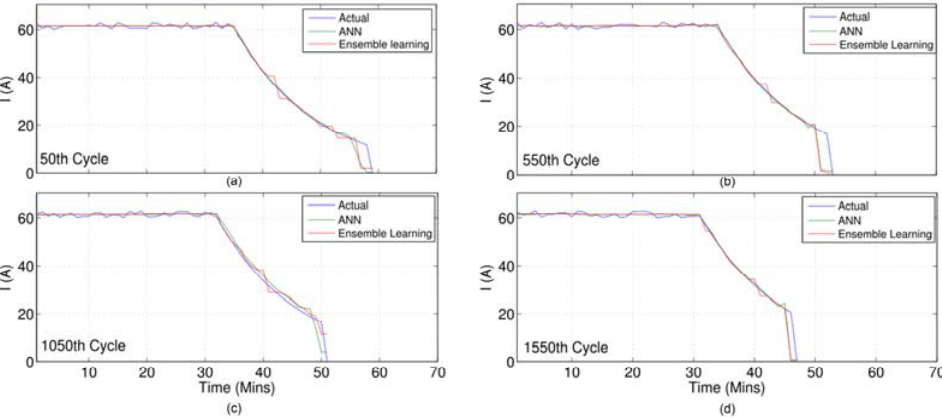
Figure 10. Charging profiles predictions for uniform aging of cells. ( a ) 50th Cycle; ( b ) 550th Cycle; ( c ) 1050th Cycle; ( d ) 1550th Cycle.